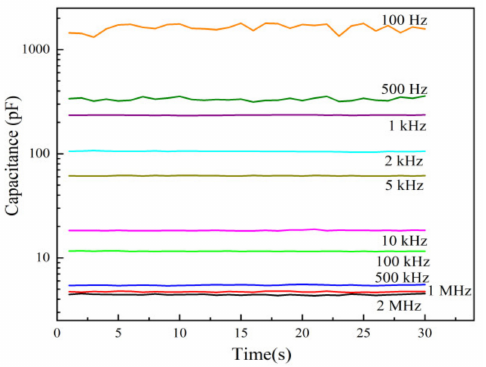
Figure 10. Capacitance stability of the sensors on ethanol-treated hydrophobic PTFE.